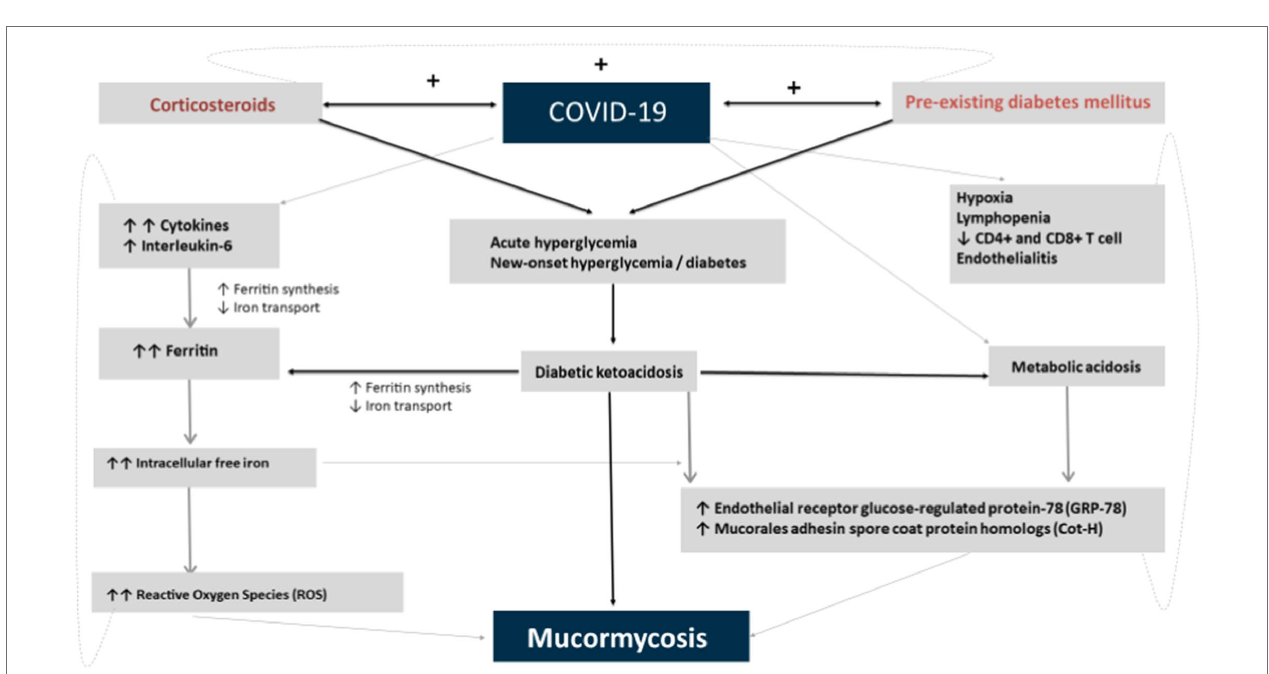
FIGURE 2 | Postulated interaction of diabetes, corticosteroid, and COVID-19 with mucormycosis.